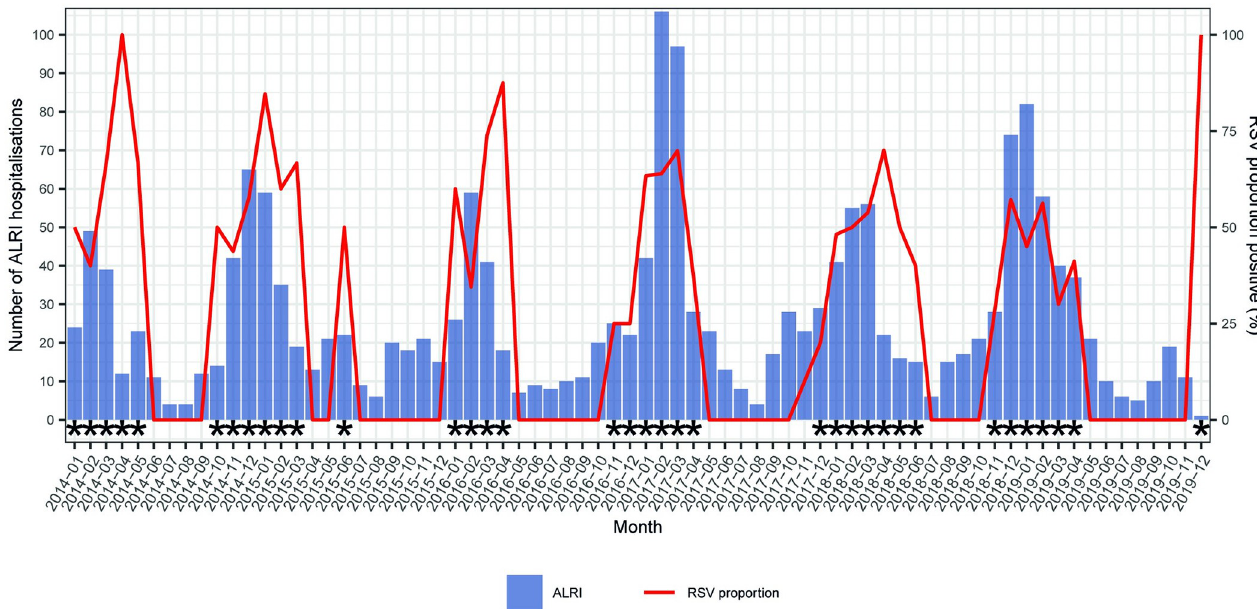
Fig 2. Seasonality of RSV during the study period. RSV = respiratory syncytial virus; ALRI = acute lower respiratory infection. Asterisks denote months with high RSV activity ( > 10% positivity rate).